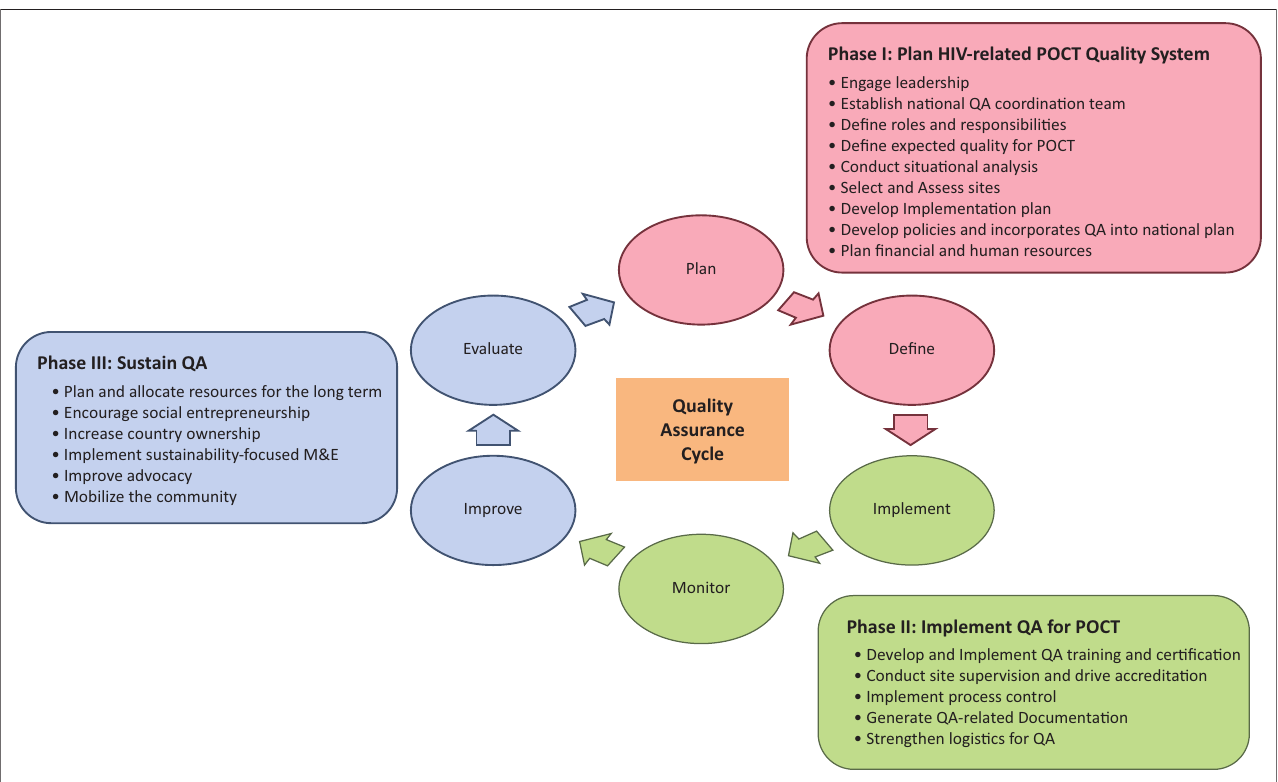
FIGURE 2: Components of a functional EQA scheme.